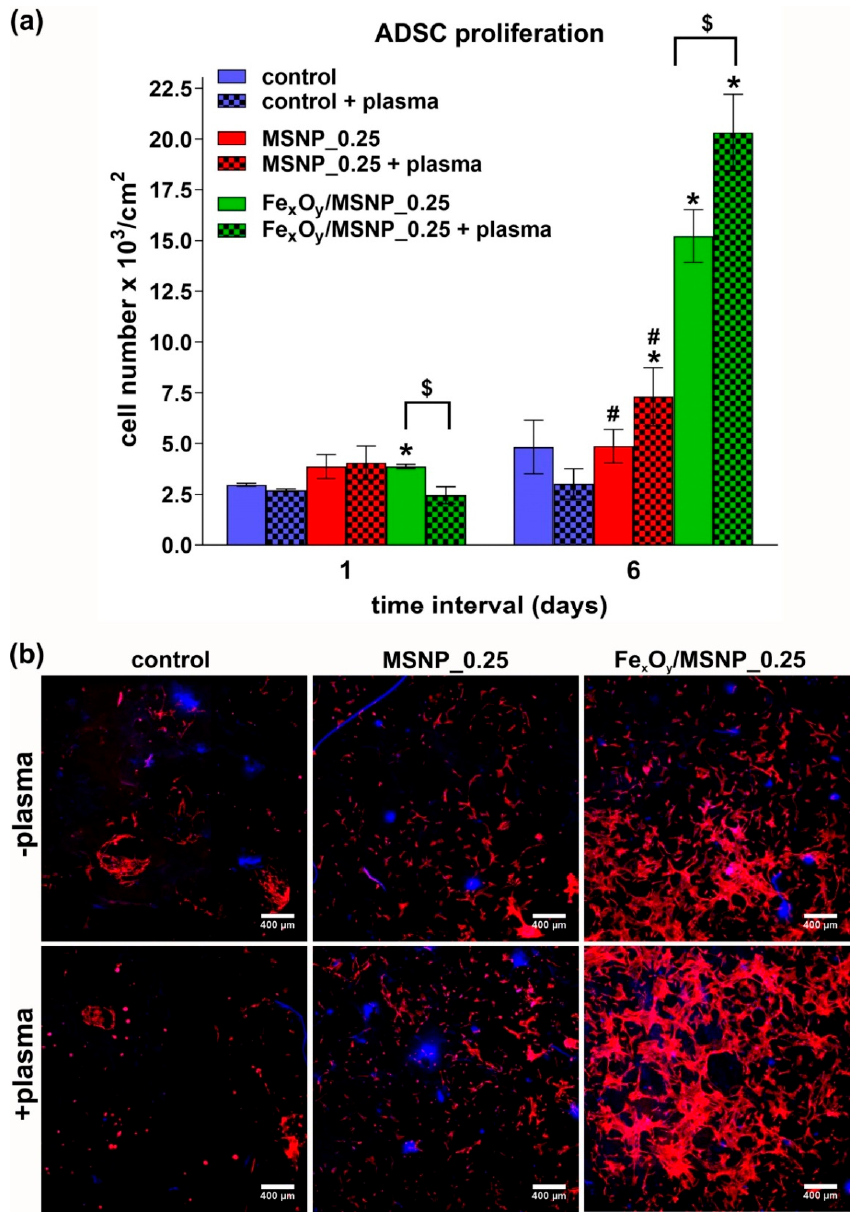
Figure 7. Proliferation of ADSCs on the surface of the NPs-loaded scaffolds upon nitrogen plasma exposure (16 s in HBSS; cells left in HBSS for 3 h after plasma treatment): ( a ) cell number increase with time determined by nuclei counting (control—biomaterial without any NPs; 0.25—concentration (wt.%) of NPs within the structure of the biomaterial; * statistically significant results compared to the corresponding (with or without plasma activation) control biomaterial, # compared to the corresponding (with or without plasma activation) biomaterial containing Fe x O y /MSNPs; $ statistically significant results between plasma-treated and untreated biomaterials, according to One-way Anova followed by Tukey’s test, p < 0.05); ( b ) CLSM images of ADSCs on the surface of the biomaterials (cells at extremely low concentration were seeded) 6 days after plasma treatment upon fluorescent staining of cytoskeleton and nuclei (red fluorescence—cytoskeleton, blue fluorescence—nuclei, magn. 40×).